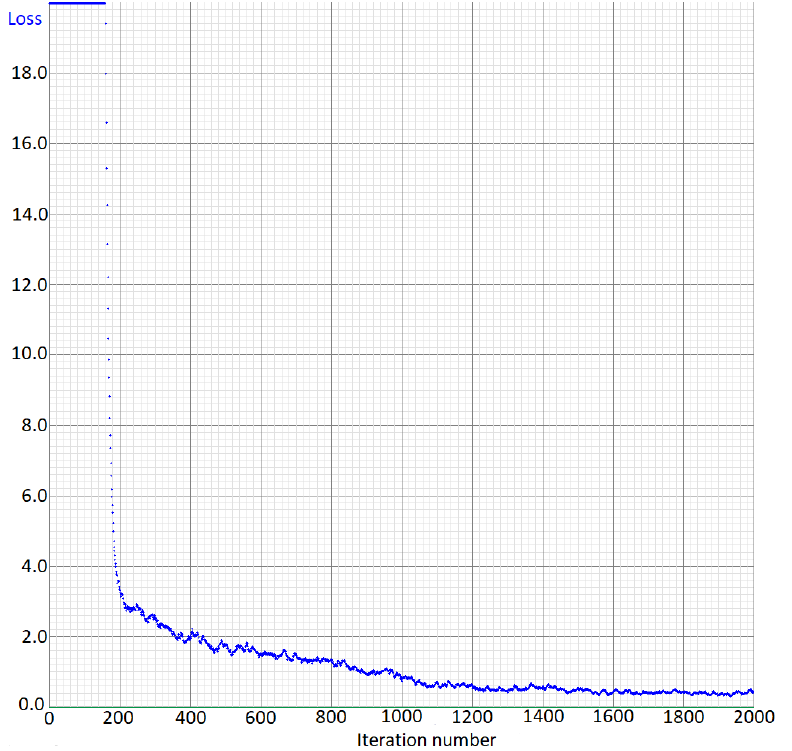
Figure 4. Loss curve of the training of the fox detection